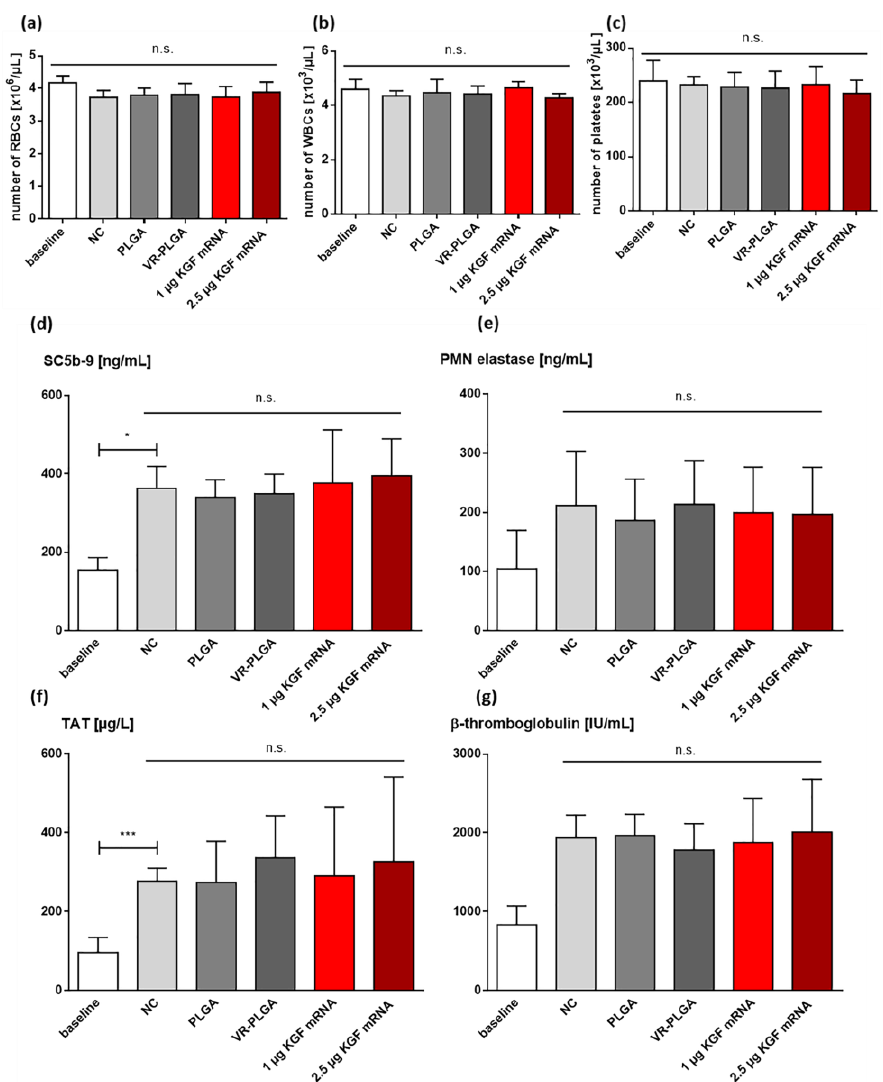
Figure 6. Hemocompatibility testing of sutures coated with PLGA and / or Viromer RED and KGF mRNA. Numbers of red blood cells (RBCs) ( a ), white blood cells (WBCs) ( b ), and platelets per microliter ( c ) were not altered in all treatment groups. The blood markers for detecting the activation of the complement system (SC5b-9) ( d ), neutrophil activation (PMN elastase) ( e ), as well as activation of the clotting cascade (TAT) ( f ) and platelets ( β -thromboglobulin) ( g ) were quantified before and after incubation in blood, using specific ELISA. ( n = 4; * * * p < 0.001, * p < 0.05, n.s. = not